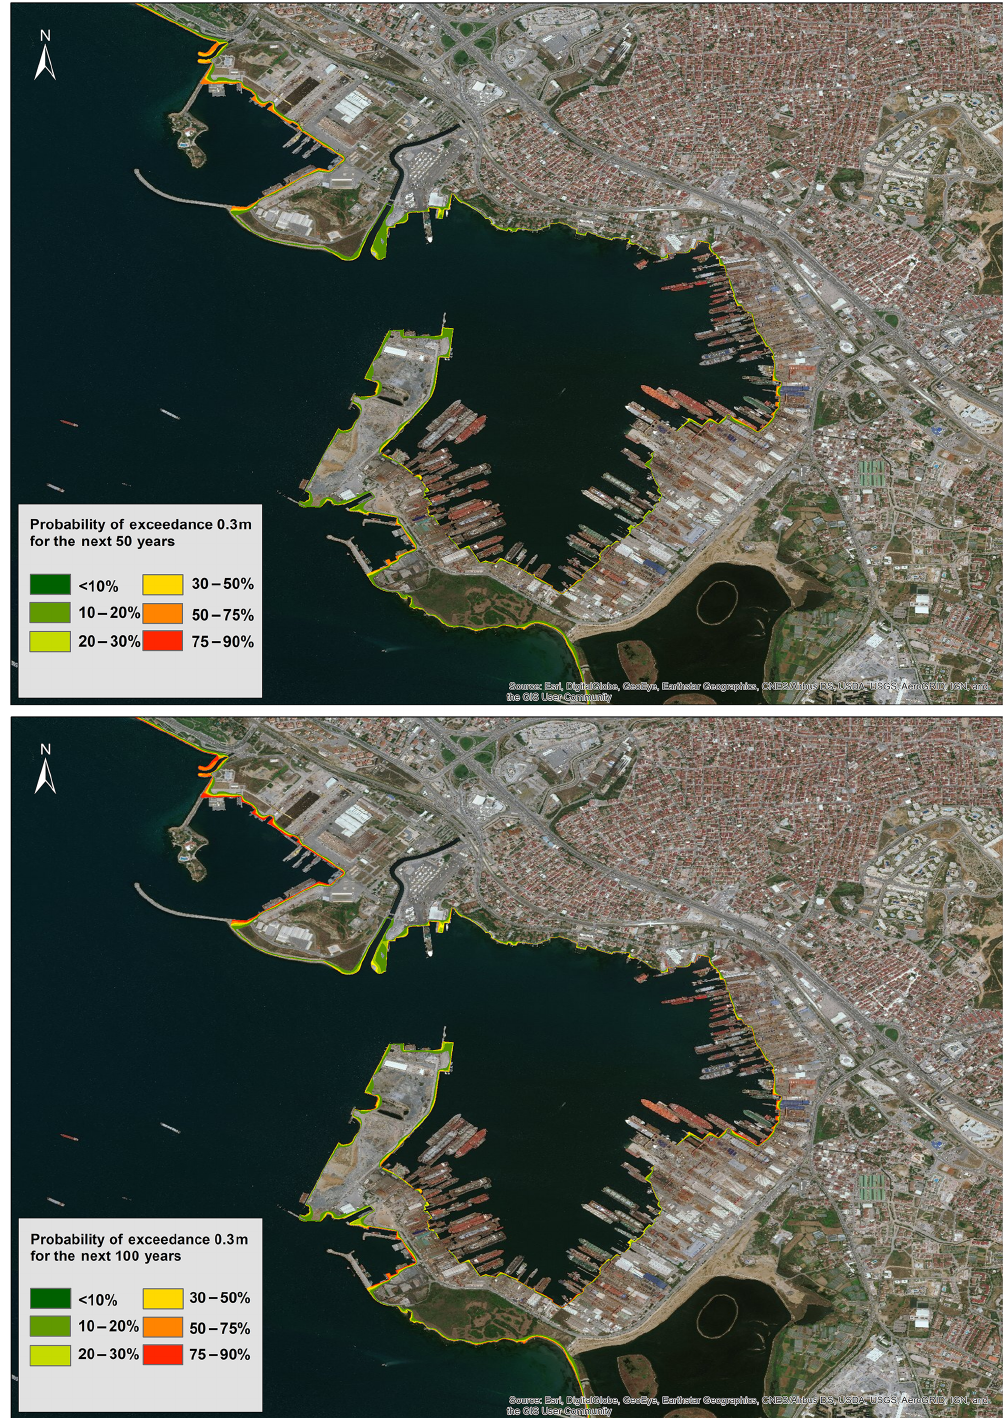
Figure 8. Probabilistic tsunami inundation maps for the Tuzla study domain representing the probability of exceedance of 0.3m inundation depth within the next 50 and 100 years. Change of colors from green to red represents the increasing probability of exceedance (created using ArcMap version